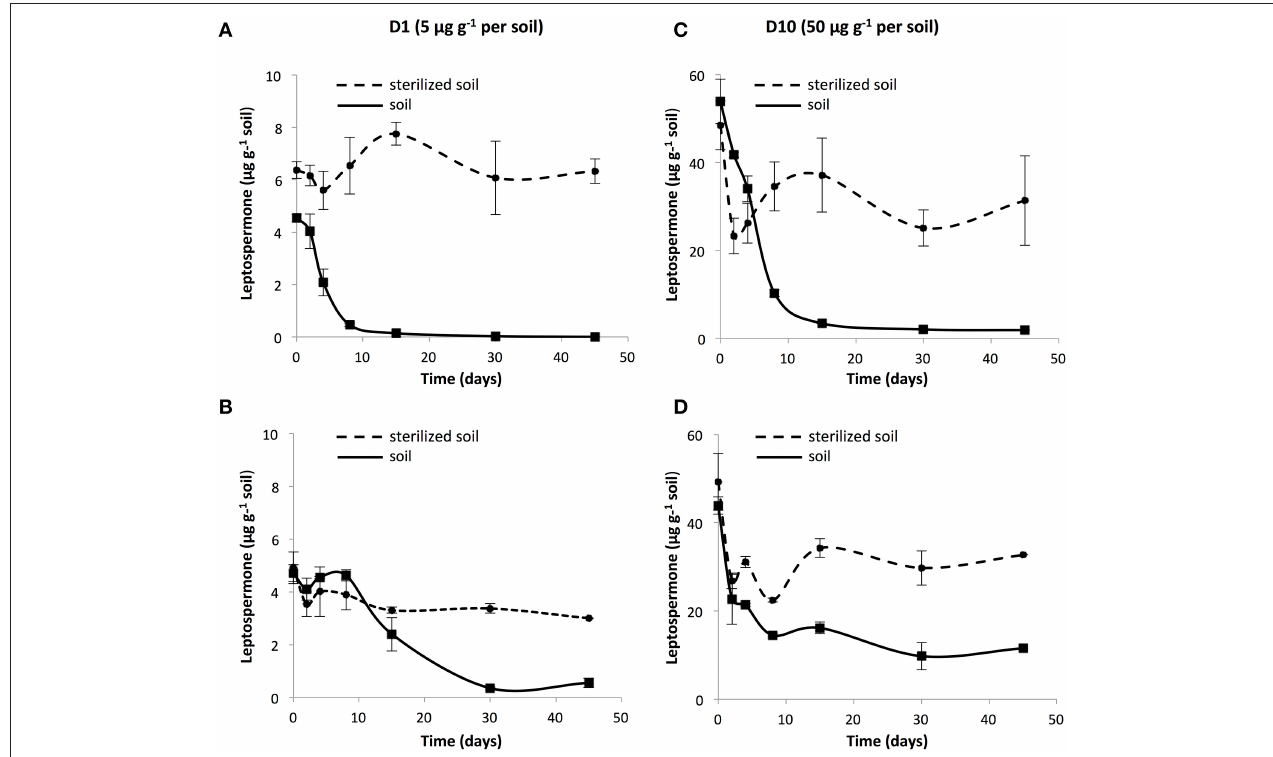
FIGURE 1 | Dissipation kinetics of 1 × recommended rate leptospermone (D1; 5 µ g g − 1 ) in sterilized ( l ) and unsterilized soils ( n ) from (A) P and (B) SJF, and 10 × the recommended rate (D10; 50 µ g g − 1 ) in the soil from (C) P and (D) SJF. Standard deviations are indicated ( n = 3).